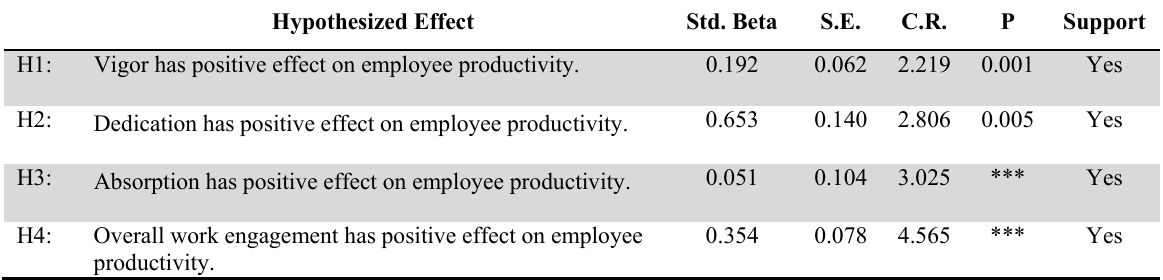
Research Findings Hypothesized Effect Std. Beta S.E. C.R. P Support